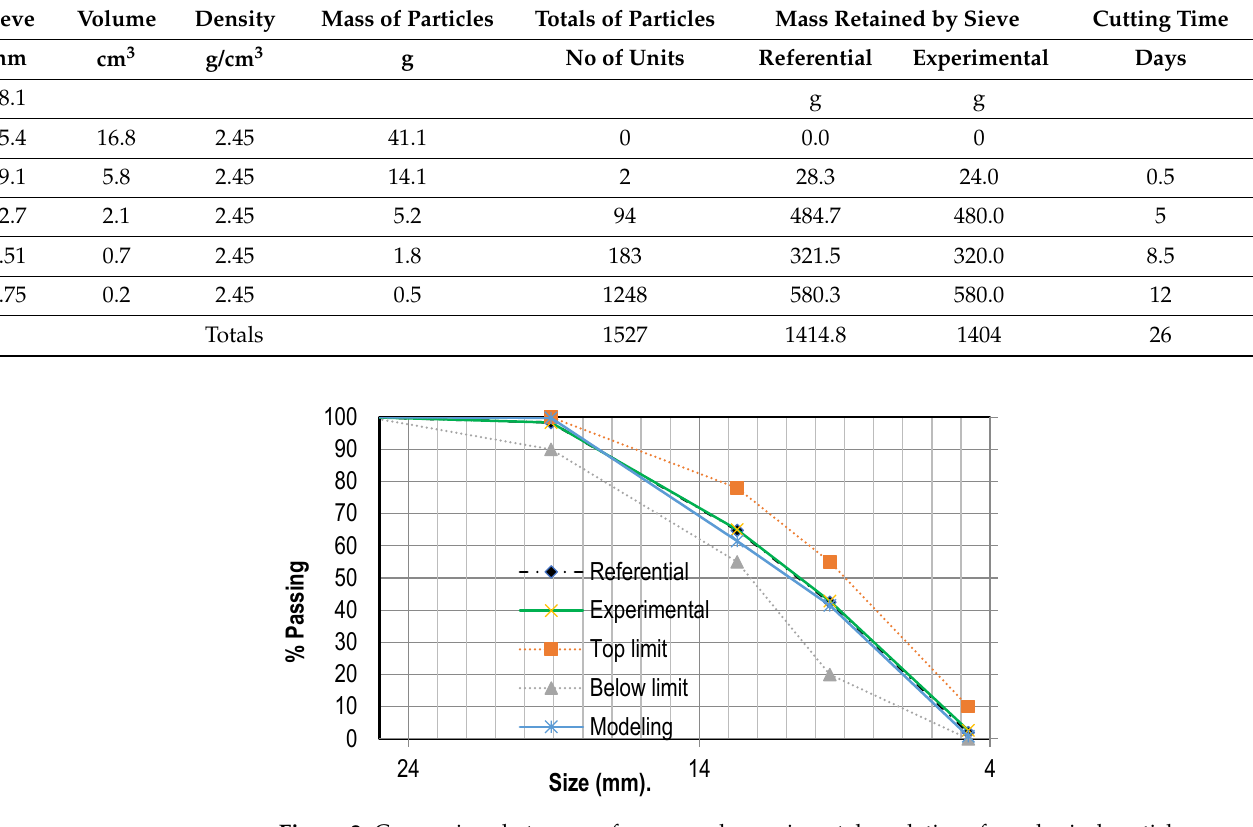
Figure 2. Comparison between reference and experimental gradations for spherical particles.